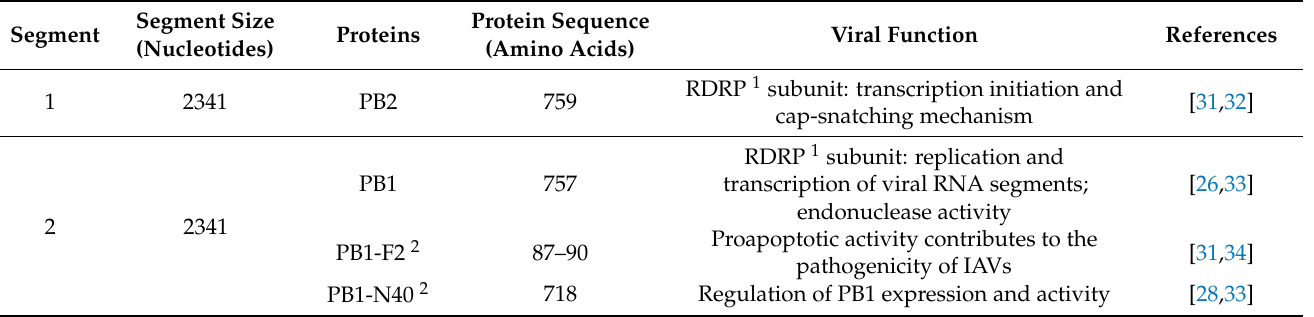
Figure 1. Influenza A virus virion structure and genome organization. ( A ) Schematic organization of a gene segment (vRNA). The IAV genes consist of three parts: 1. Untranslated regions (UTRs) comprise the universal primers uni-12 (12nt) and uni-13 (13nt) at the end of 3 ′ and 5 ′ of each segment, which are highly conserved among the eight gene segments and among all IAV viral strains; and the segment-specific non-coding regions (ssNCRs); 2. Packaging signals; and 3. Coding region. ( B ) IAV Genome organization: The eight negative-sense, single-stranded RNA segments of IAV genome code for PB2, PB1, PA, HA, NP, NA, M and NS, respectively (indicated in white boxes). The darker blue colour boxes at the end of each vRNA segment indicate the 3 ′ and 5 ′ untranslated regions (UTRs); the lighter blue colour boxes indicate the packaging signals. The numbers inside the blue boxes represent the nucleotide length for the UTRs and the packaging signals. ( C ) IAV virion structure: IAV comprises three components: an envelope made of a lipid bilayer containing three transmembrane proteins (HA, NA and M2 ion channel); a layer of the inner surface envelope M1; and a core made of eight vRNA segments, packaged together to form vRNP. (Created with BioRender.com (accessed on 18 March 2023)). Table 1. Influenza A virus gene segments and proteins’ size and functions. 1 RNA-dependent RNA polymerase (RDRP); 2 Auxiliary proteins.